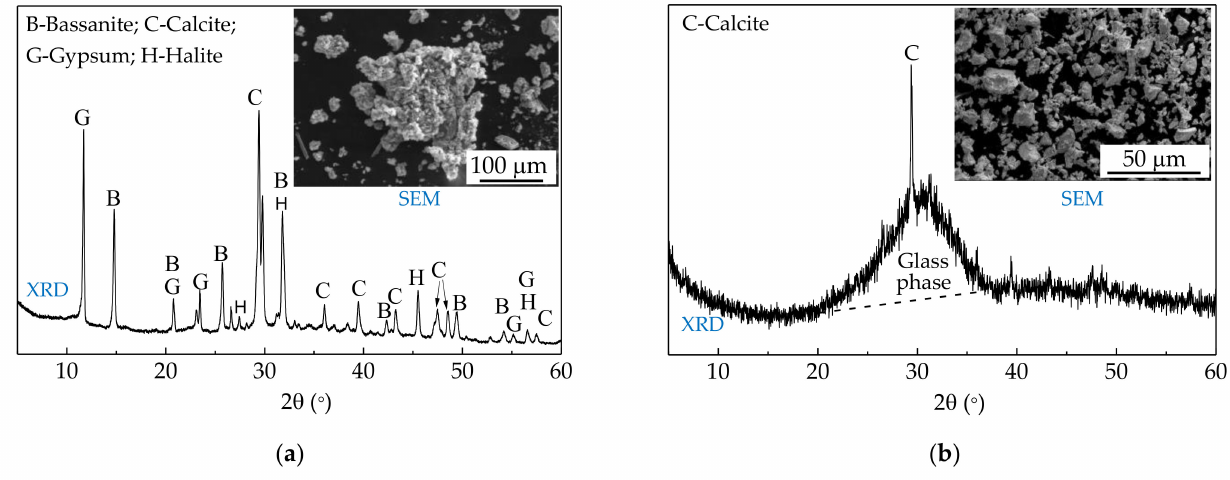
Figure 1. XRD patterns and SEM images: ( a ) SR; ( b )